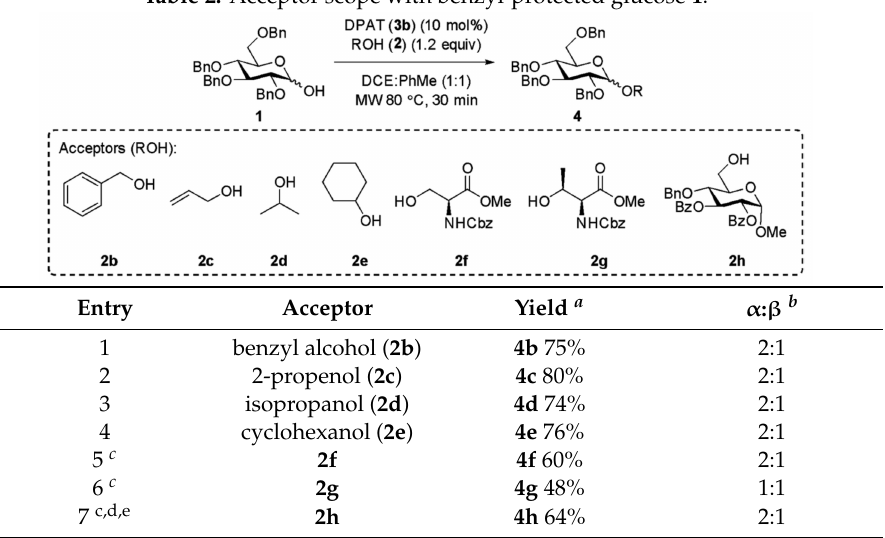
Table 2. Acceptor scope with benzyl-protected glucose 1